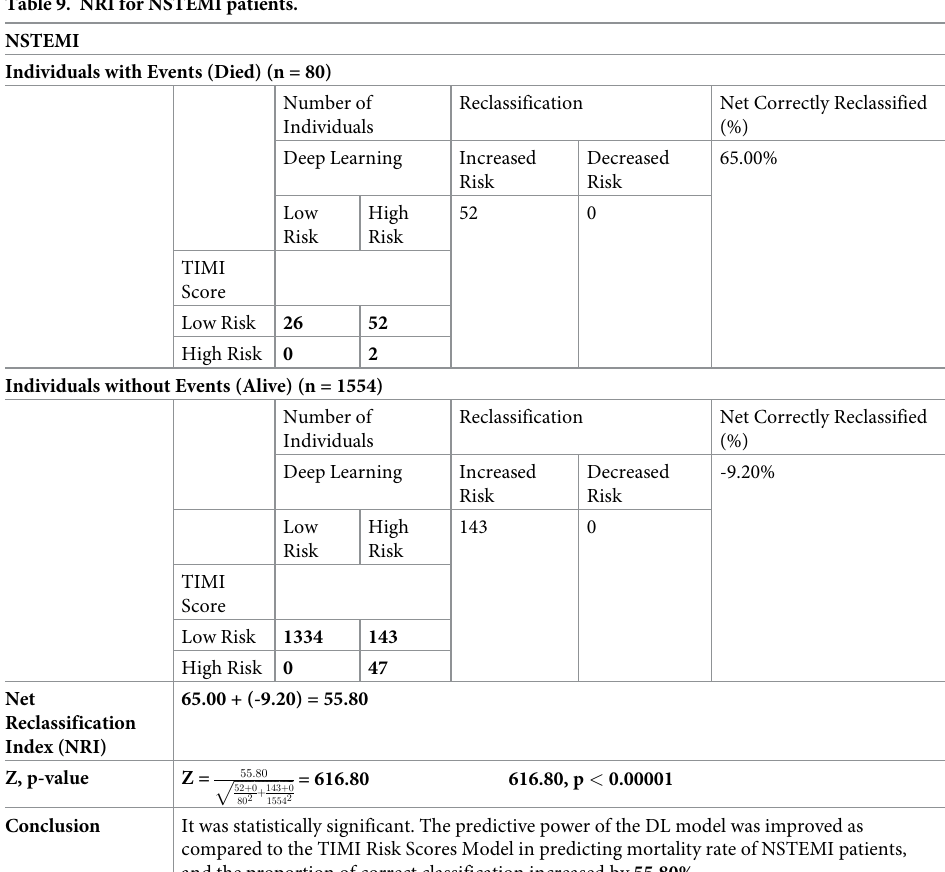
Table 9. NRI for NSTEMI